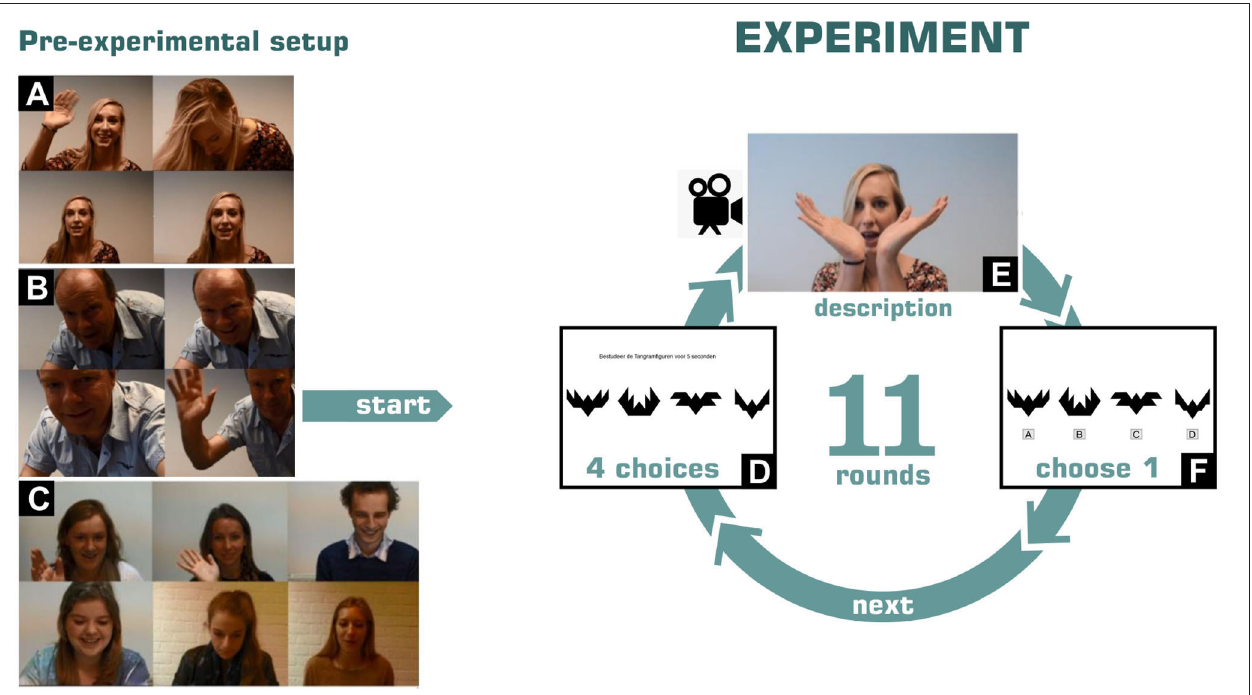
FIGURE 1 | Visual impression of the o-cam experiment. First the participant is prepared (A–C) , after that 11 rounds are played: In each round the participant is shown 4 figures (D) , followed by a description of 1 of those figures (E) , and after which participant indicates which figure is described (F)